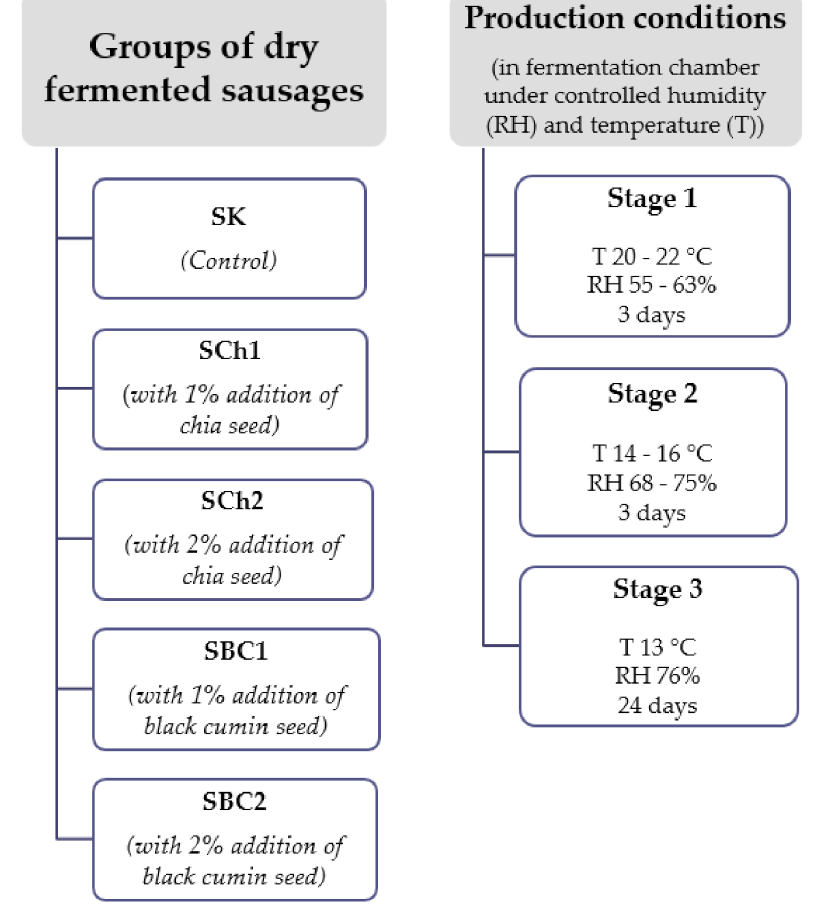
Figure 1. The groups of dry fermented sausages and production